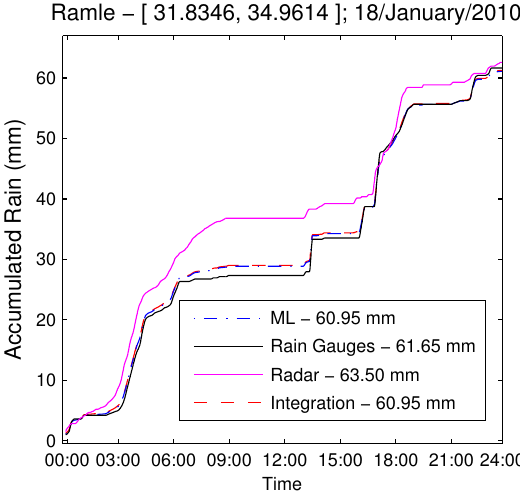
Figure 18. Accumulated rain intensity (mm) for the Ramle site, with 30 ML surrounding the site on 18 January 2013 (24h of Fig. 18. The accumulated rain intensity (mm) for Ramle site, with 30 ML surrounding the site at 18/Jan/2013 (24 hours of rain event)